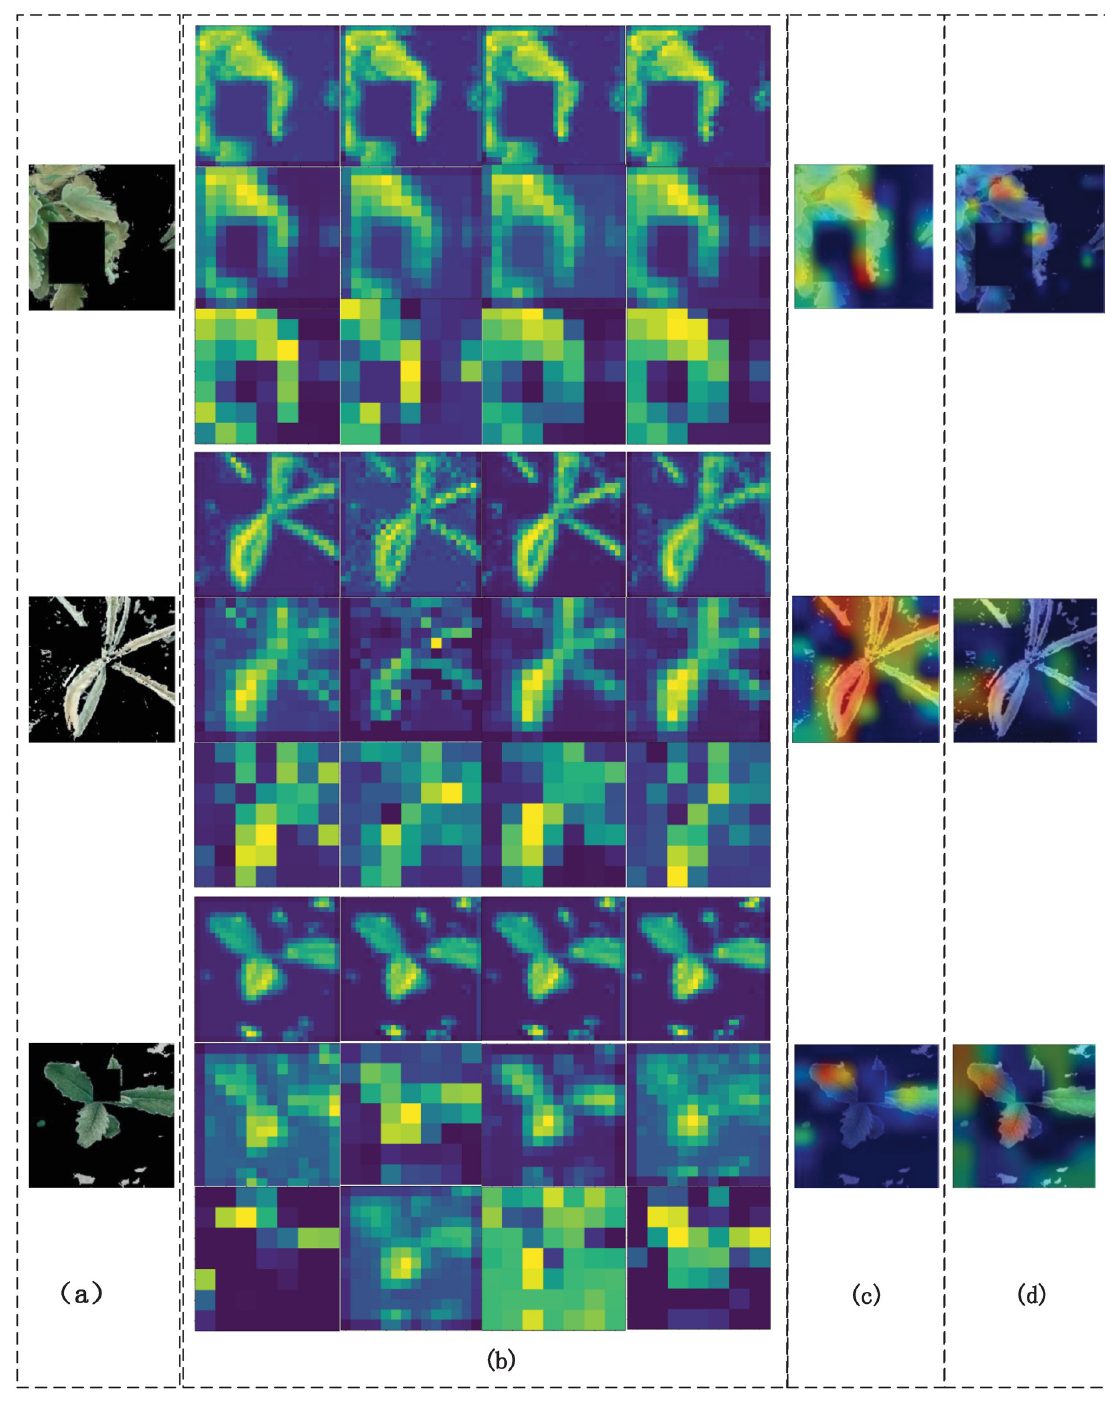
Fig 11. The influence of autoencoding network on the overall model. (a) Image input to autoencoder network, (b) Result of last two convolutional layers and last pooling layer of autoencoder network, (c) Class activation E-A-Net autoencoder network partial characteristic diagram, (d) Class activation basic neural network